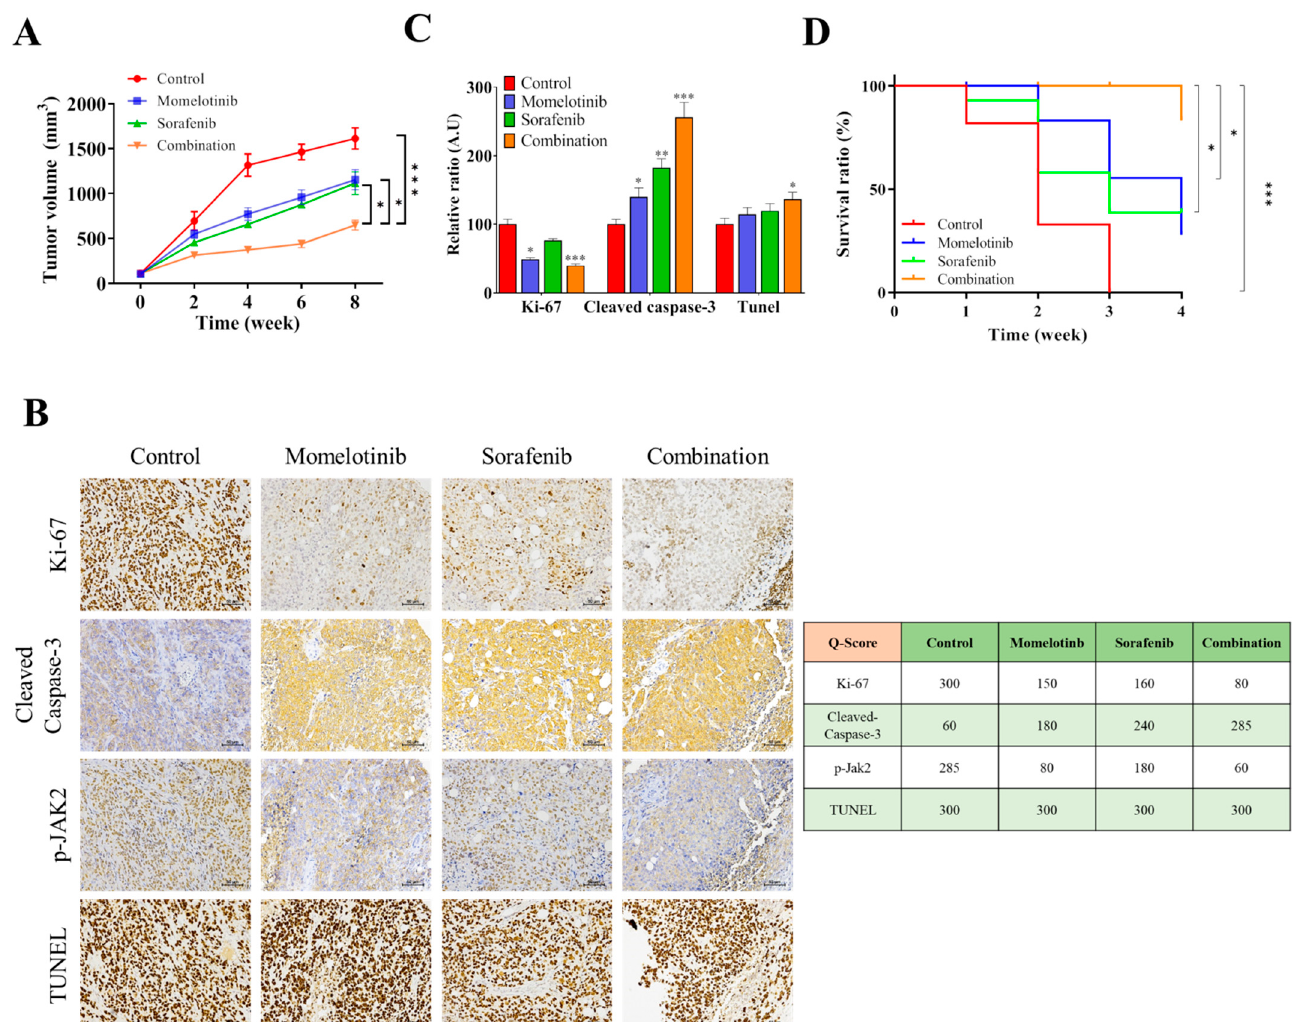
Figure 7. Momelotinib and sorafenib, in combination, potentiate the anti-proliferative effect of the single drug treatments in vivo. ( A ) The tumor volume over the time curve, the reduction in tumor burden was seen in combination treatment, as compared to the individual treatment groups. ( B ) Representative hematoxylin and eosin (H&E) stained images are shown, and IHC detected the expression of Ki-67 and cleaved caspase-3, p-Jak2 as the expression of activated Jak2 in the tumors. in the tumors. In addition, apoptotic cells in the tumors from mice were detected by the TUNEL assay. ( C ) The data were quantified and are represented as the means ± SD from 3 independent experiments. Combination vs. Momelotinib *** p < 0.01; combination vs. sorafenib * p < 0.05 and ** p < 0.01. Scale bar: 100 µ m. ( D ) The overall survival rate of Xenograft